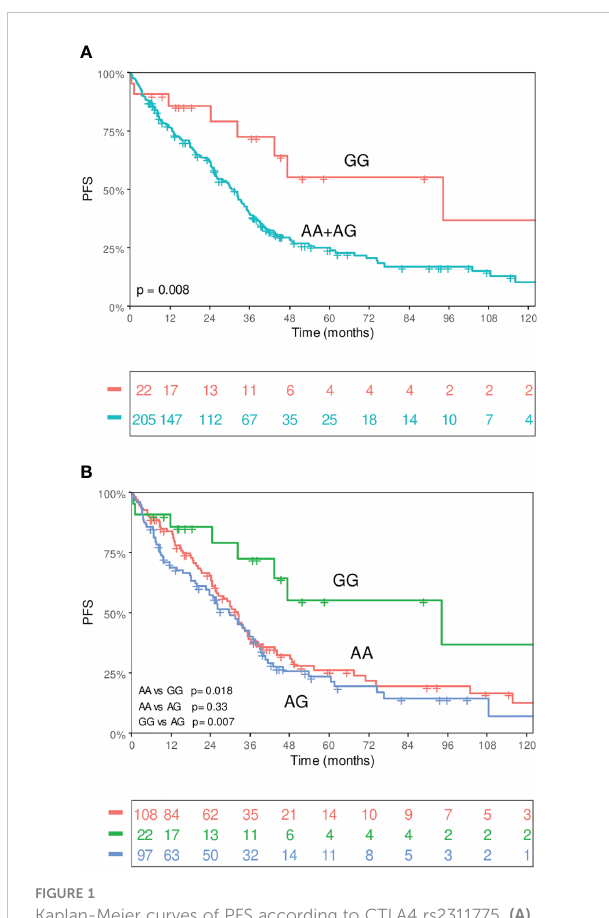
FIGURE 1 Kaplan-Meier curves of PFS according to CTLA4 rs2311775. (A) grouped phenotypes and (B) independent genotypes.